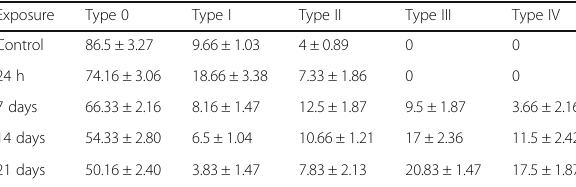
Table 3 Nucleoids in various damage degrees in the kidney